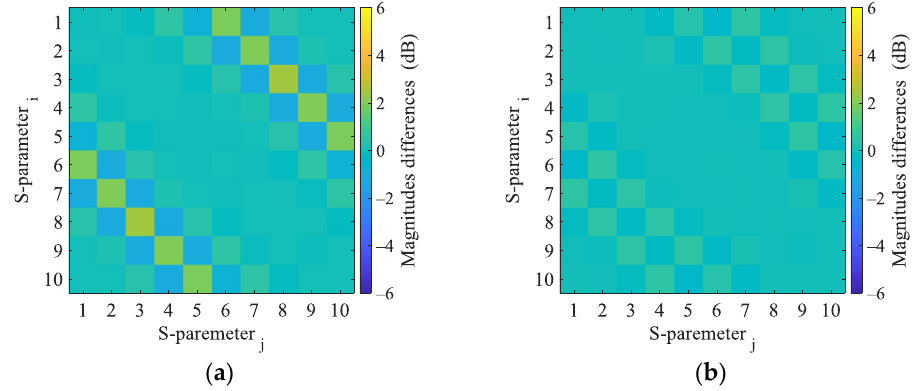
Figure A7. 3D numerical simulations. Magnitudes difference of 3D numerical model induced by the virtual presence of a 4 cm radius ( a ) hemorrhagic and ( b ) ischemic stroke located at position (0, 0).